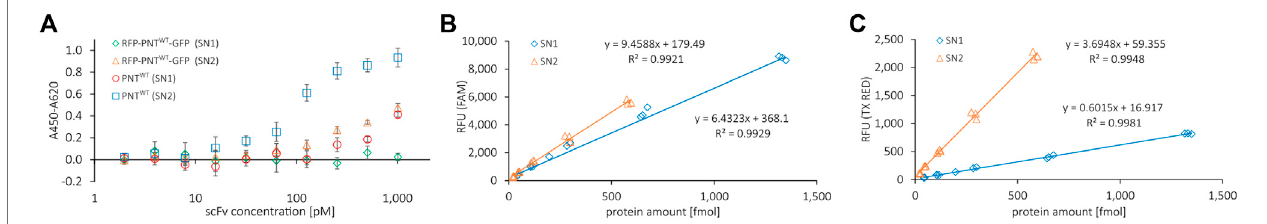
FIGURE 3 | ELISA binding curve of reporter RFP-PNT WT -GFP and correlation of fl uorescence signal with protein amount determined by liquid scintillation. (A) Indirect ELISA binding curve for anti-EGFR scFv with (RFP-PNT WT -GFP) and without (PNT WT ) N- and C-terminal fl uorescent reporter proteins against EGFR. PNT WT protein amount per well was normalized according toyields determined by liquid scintillation. Mean values were derived from sample triplicates by subtracting the signal ofwellswithoutantigenfromthesignalofwellswithantigen.Errorbarsrepresentthestandarddeviation. (B) FAMchanneland (C) TexasRedchannel fl uorescence emitted per fmol of protein for RFP-PNT WT -GFP from SN1 and SN2 fractions.